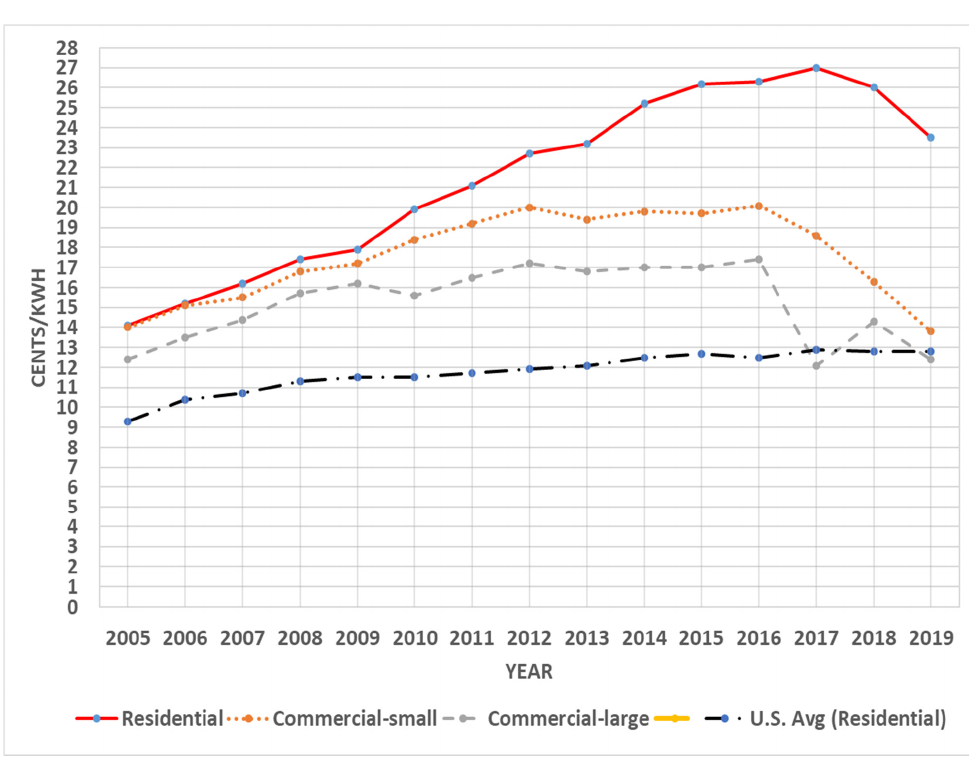
Figure 1. UPPCO’s electricity price by sector and the average U.S. price from 2005–2019. Sources: Author, based on MPSC data on comparison of average rates (in cents per kWh) for MPSC-regulated electric utilities in Michigan [9].